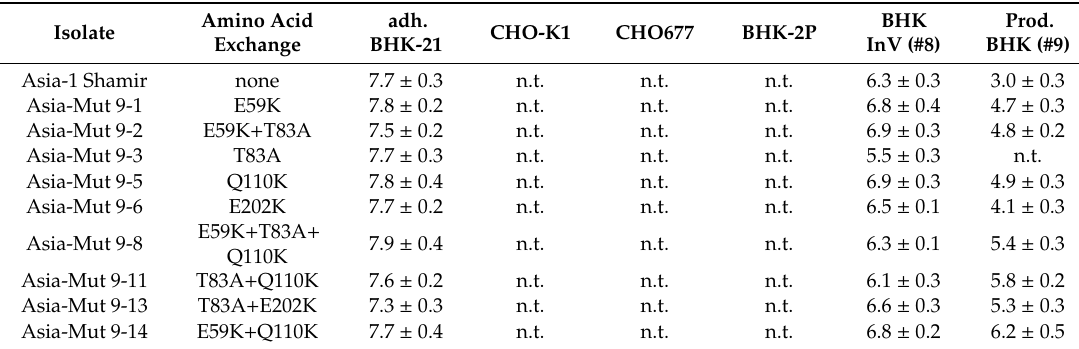
Table 4. Mean and standard deviation of viral titers (log 10 TCID 50 / mL) of recombinant viruses based on Asia-#9 that were not able to infect and replicate in BHK-2P suspension cells. A lack of replication was assumed for all virus / cell combinations for which fewer than two of three replicate cultures were positive in the FMDV RT-qPCR. Amino Acid adh. Exchange BHK-21